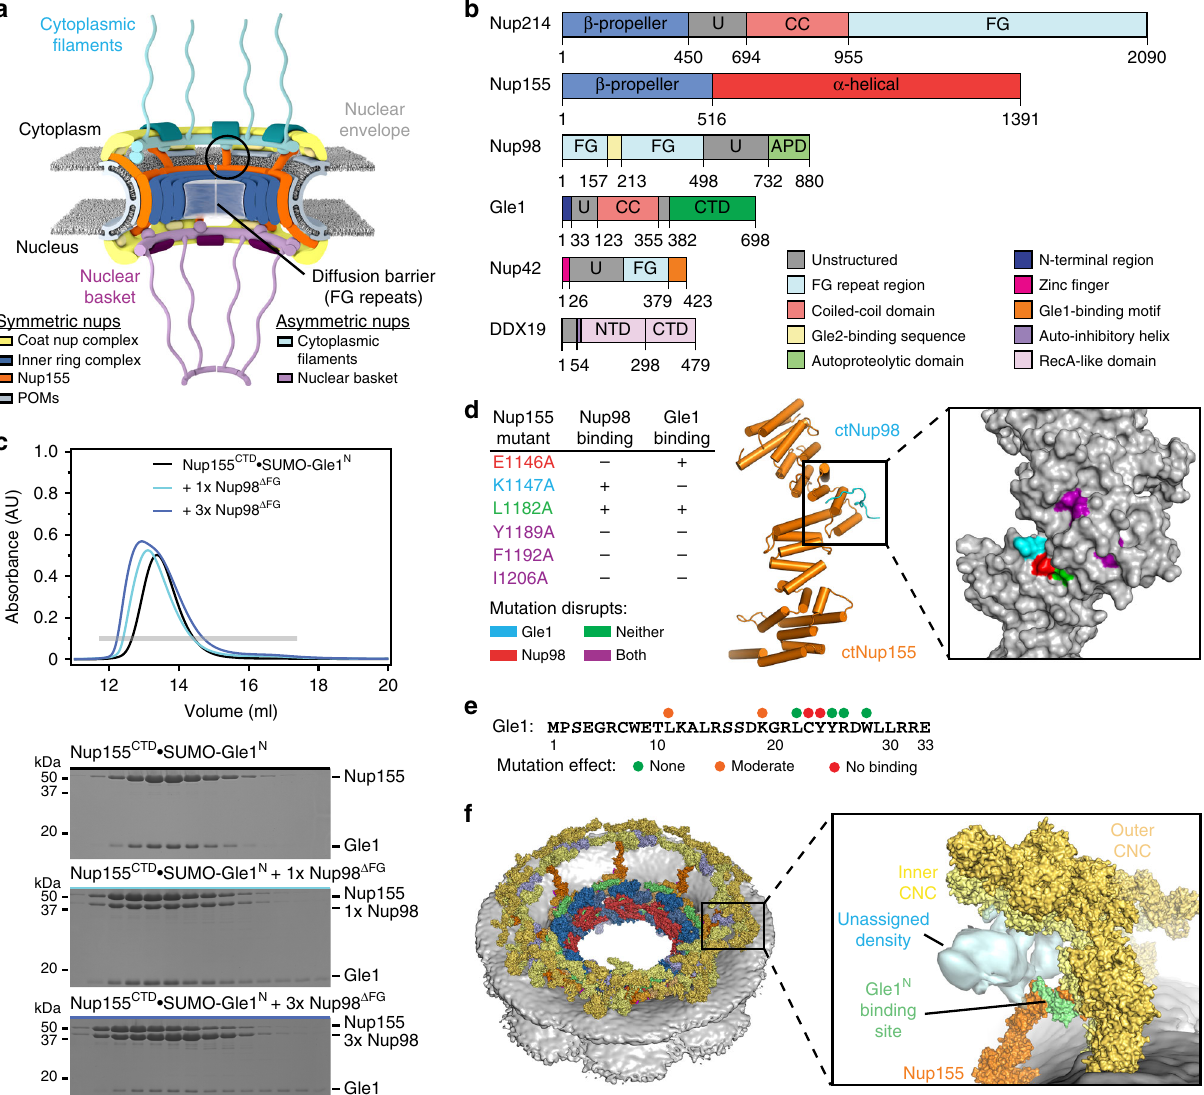
Fig. 1 Gle1 is anchored to the nuclear pore complex through a competitive interaction with Nup98. a Cartoon schematic of the human nuclear pore complex (NPC). The circle highlights the region of the NPC to which the proteins used in this study localize. b Domain schematics for nucleoporins used in this study. Protein names and boundaries correspond to the human proteins. c Size exclusion chromatography (SEC) analysis of the interaction between Nup155 CTD , SUMO-Gle1 N , and Nup98 Δ FG . Puri fi ed Nup155 CTD (cid:129) SUMO-Gle1 N complex was mixed with the indicated amounts of Nup98 Δ FG and loaded onto a Superdex 200 10/300 GL column. The gray bar indicates the fractions visualized with Coomassie-stained SDS-PAGE gels. d Left: table summarizing SEC analysis of Nup155 CTD variants for Nup98 Δ FG and SUMO-Gle1 N binding. See also Supplementary Fig. 2. Right: the homologous positions were colored on the C . thermophilum Nup170 (cid:129) Nup145N structure (PDB ID 5HB0), indicating that the same binding surface is recognized by Nup98 Δ FG and SUMO-Gle1 N [2]. e Summary of the effect of Gle1 N alanine substitution variants on Nup155 CTD binding. Colored dots above the sequence of Gle1 N indicate the effect of the substitution, green for wild-type levels of complex formation, orange for reduced binding, or red for complete disruption. See also Supplementary Fig. 2. f Identi fi cation of the Gle1 binding site suggests that the unassigned cytoplasmic density adjacent to bridging Nup155 molecules could contain Gle1 and its binding partners. Left: surface representation of the composite structure of the NPC 2 . Right: zoomed view of unassigned cytoplasmic density, with Nup155 shown in orange, Gle1 N binding site colored in green, and coat nucleoporin complexes shown in